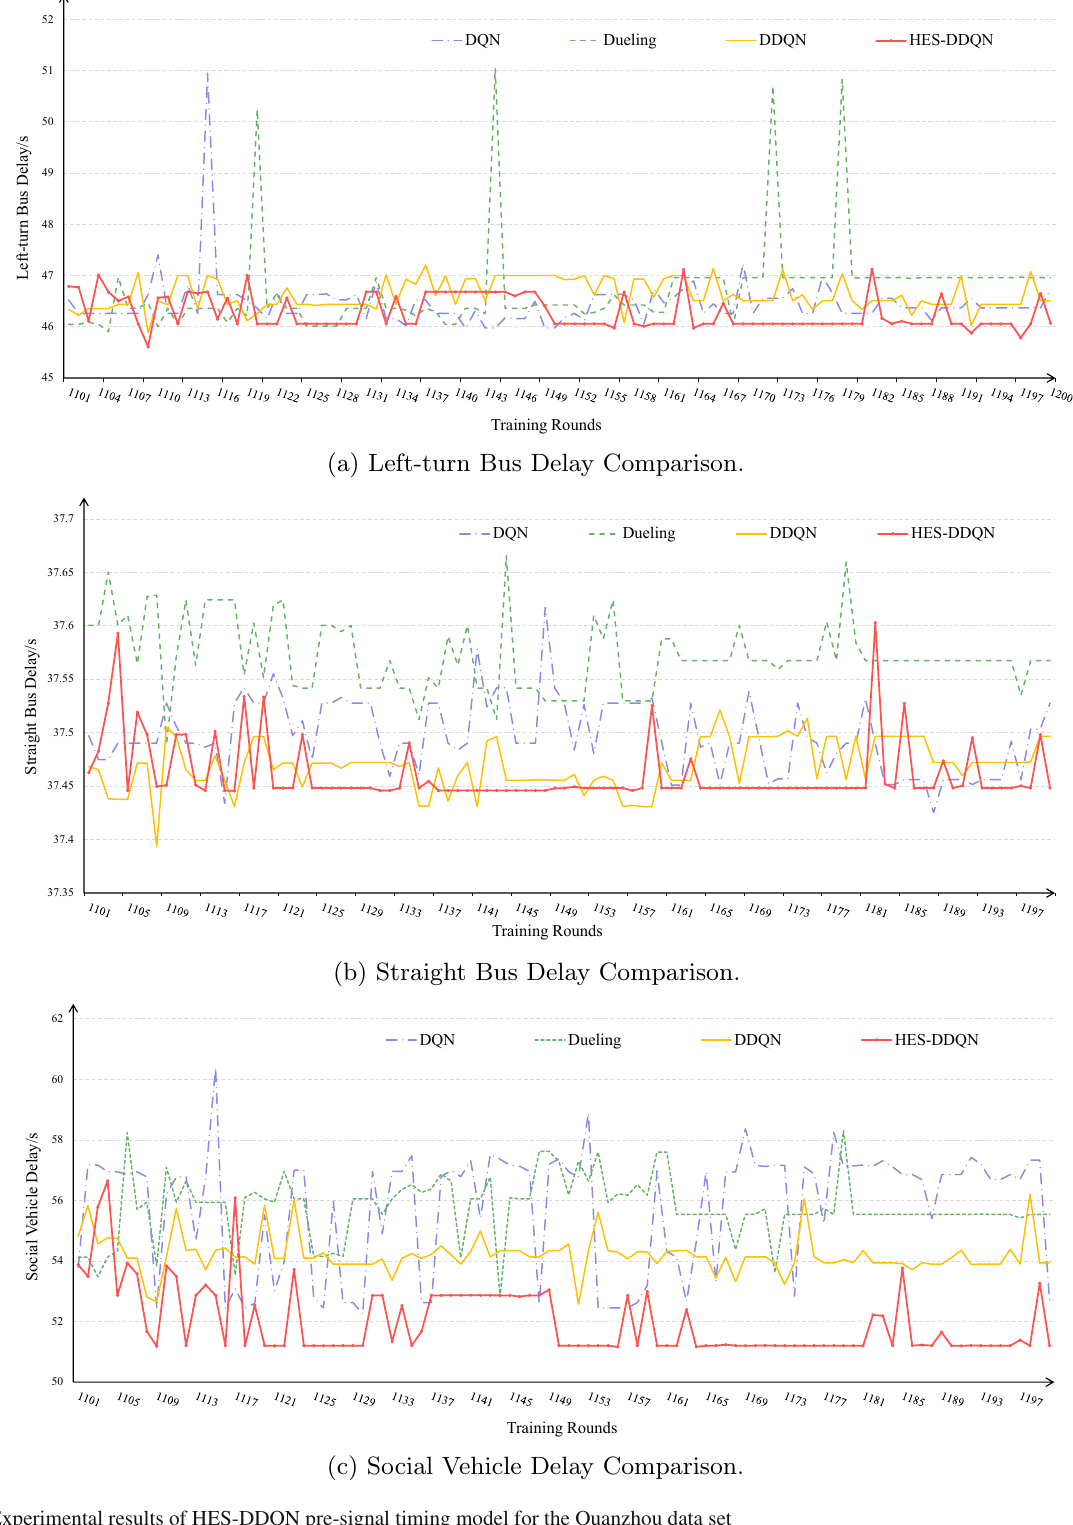
(c) Social Vehicle Delay Comparison. Fig. 7 Experimental results of HES-DDQN pre-signal timing model for the Quanzhou data